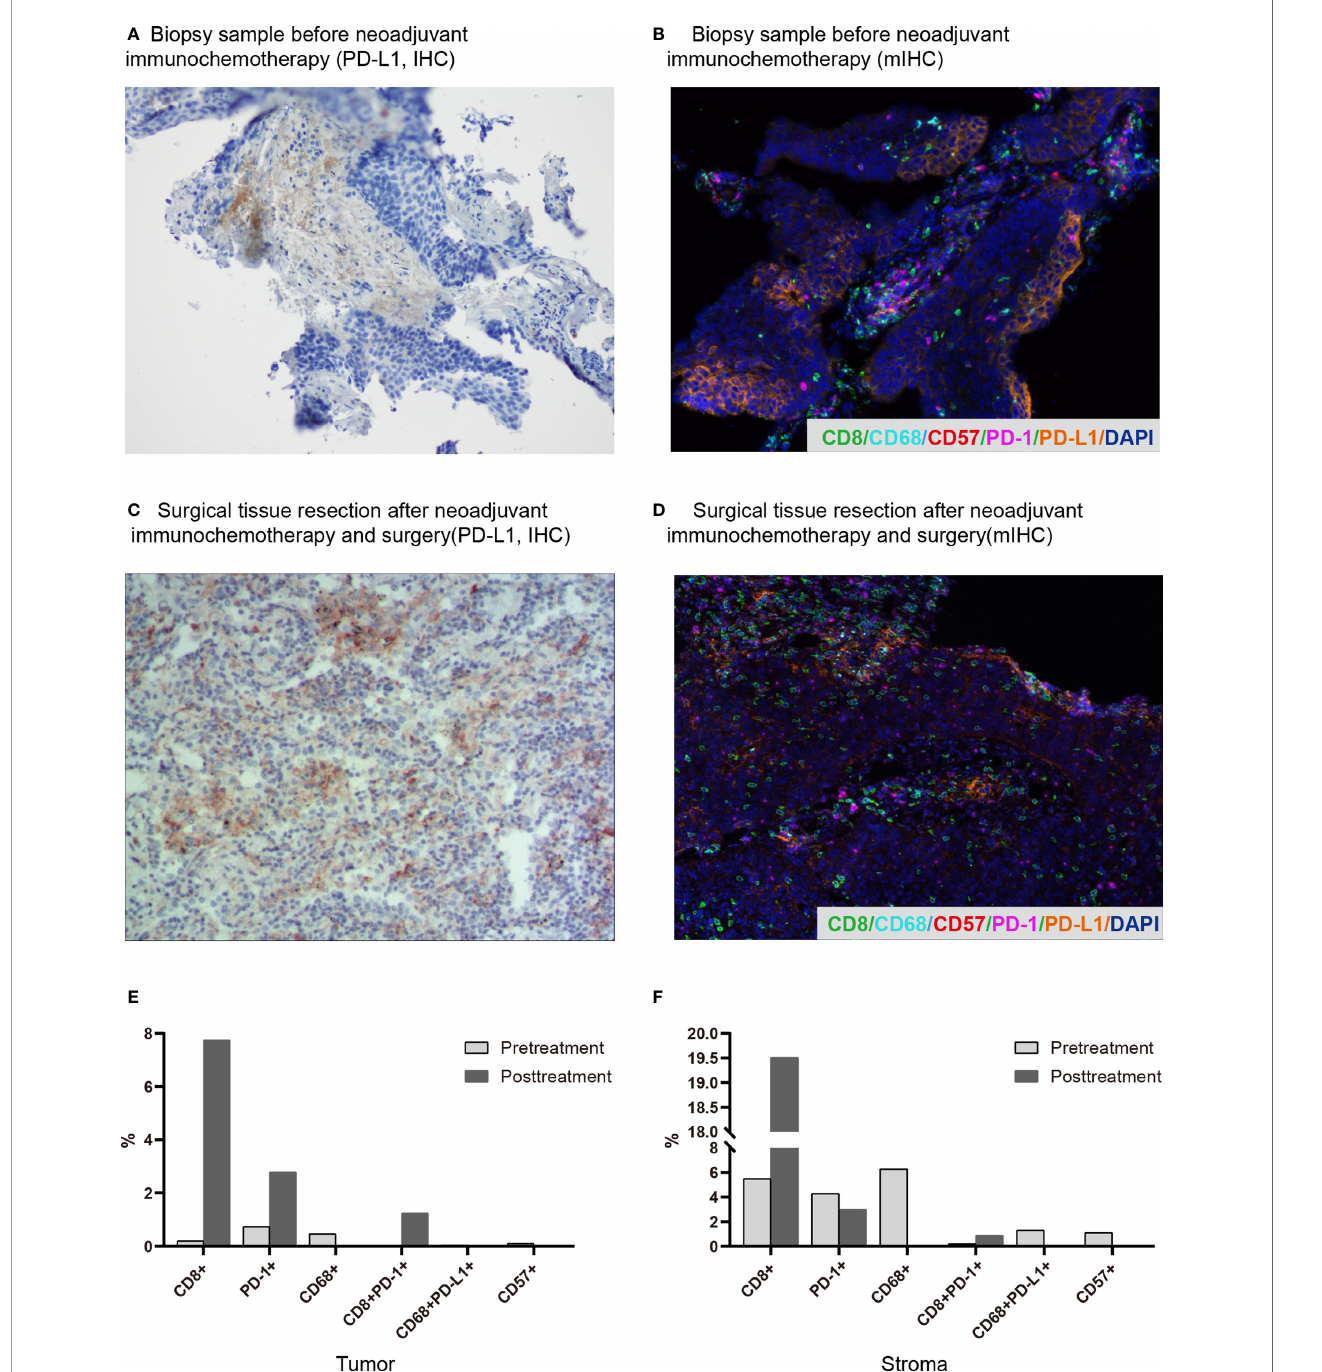
FIGURE 3 | Changes in the immune microenvironment before and after neoadjuvant immunochemotherapy. (A) Biopsy before neoadjuvant immunochemotherapy (PD-L1, IHC). (B) Surgically resected tissue after neoadjuvant immunochemotherapy and surgery (PD-L1, IHC). (C) Representative images of the pretreatment biopsy (multiplex immuno fl uorescence staining, magni fi cation, ×200). (D) Representative images of surgically resected tissue (multiplex immuno fl uorescence staining, magni fi cation, ×200). With this staining technique, visible structures include CD8 + T cells (green), CD68 + macrophages (cyan), CD57 + cells (red), PD-1 + cells (magenta), and PD-L1 + cells (orange). (E, F) Quantitative multiplex immunohistochemistry results of pretreatment and posttreatment samples in the tumor and stroma